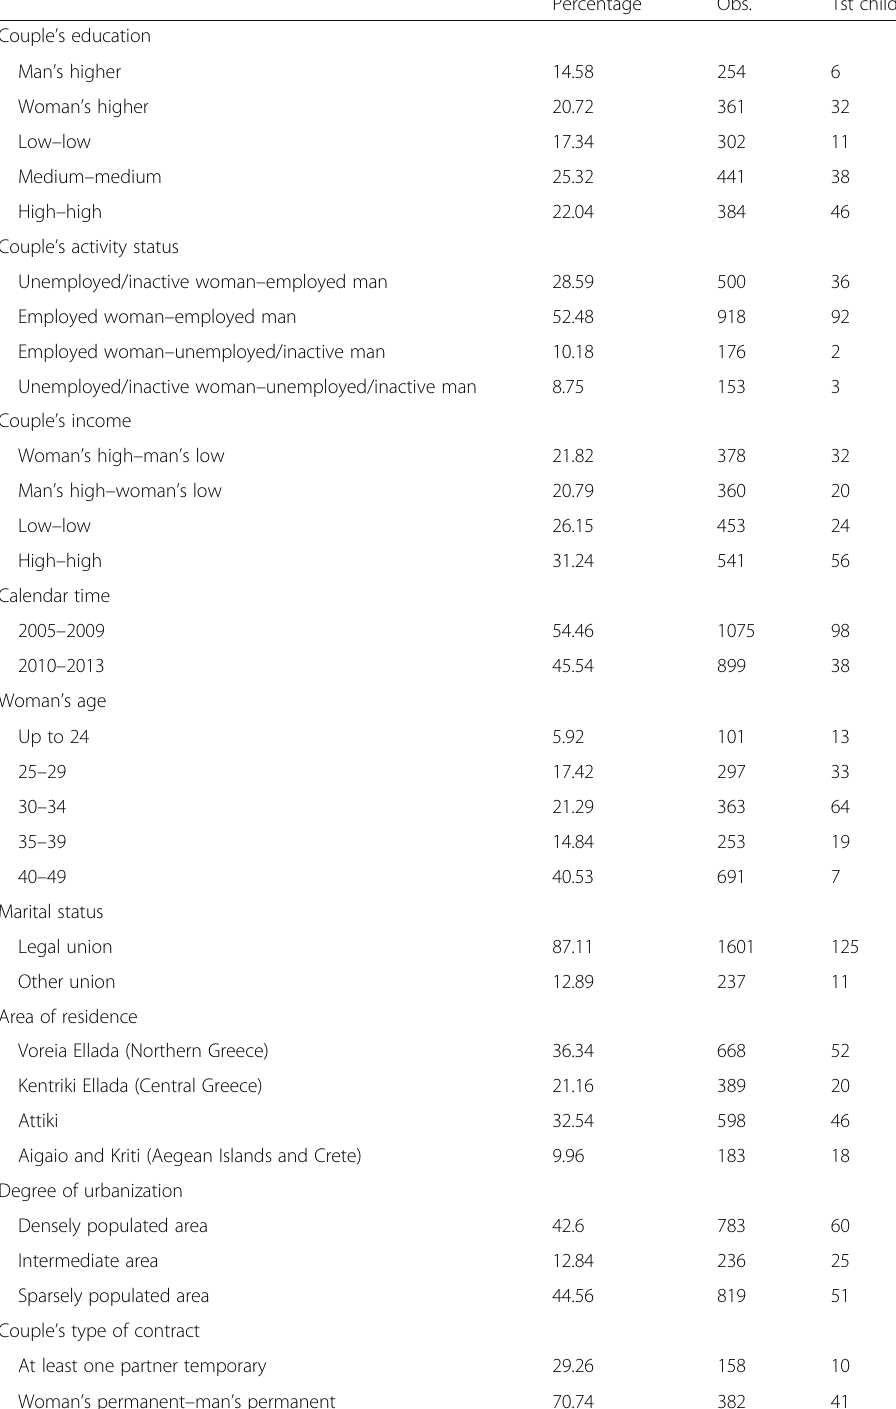
Percentage Obs. 1st child